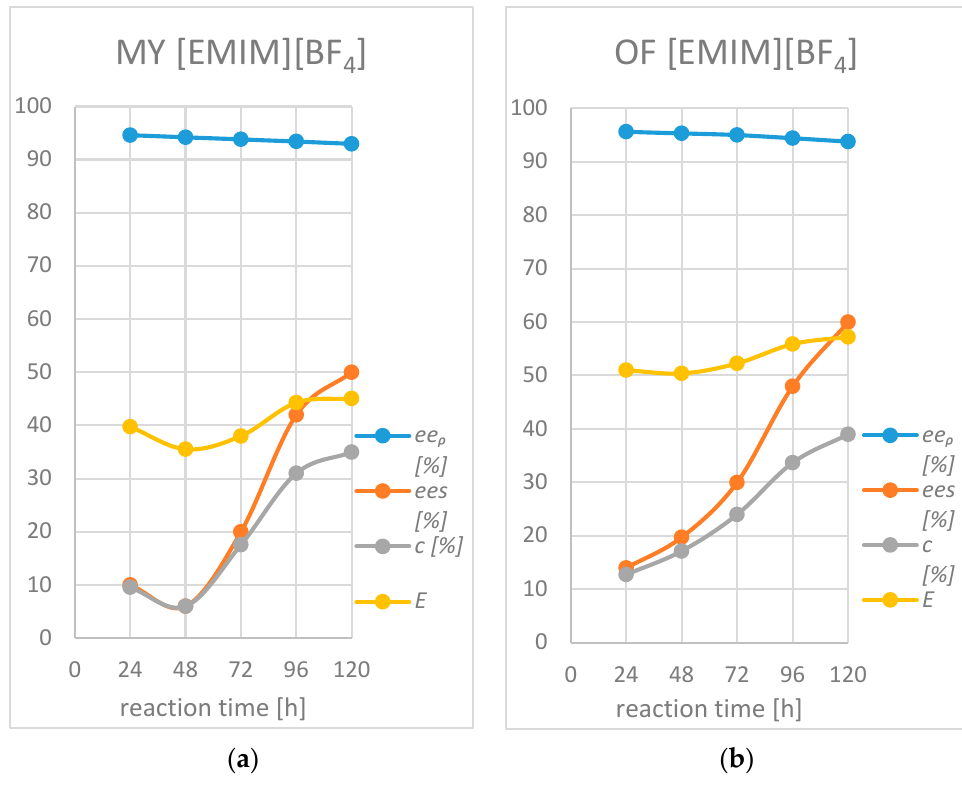
Figure 2. Effect of reaction time on the enzymatic parameters of performed kinetic resolution of ( R , S )-atenolol in two-phase catalytic system consisting of [EMIM] [BF 4 ] and lipase from Candida rugosa OF ( a ) or Candida rugosa MY ( b ) including values of both enantiomeric excesses of substrates ( ee s ) and products ( ee p ) as well as conversion ( c ) and enantioselectivity ( E